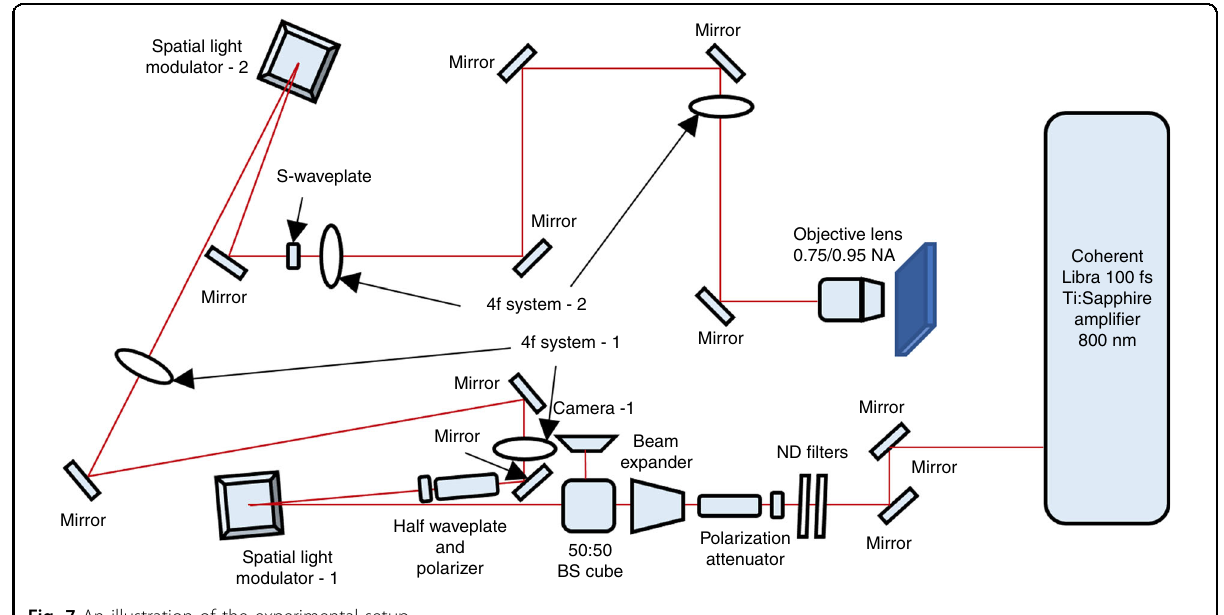
Fig. 7 An illustration of the experimental